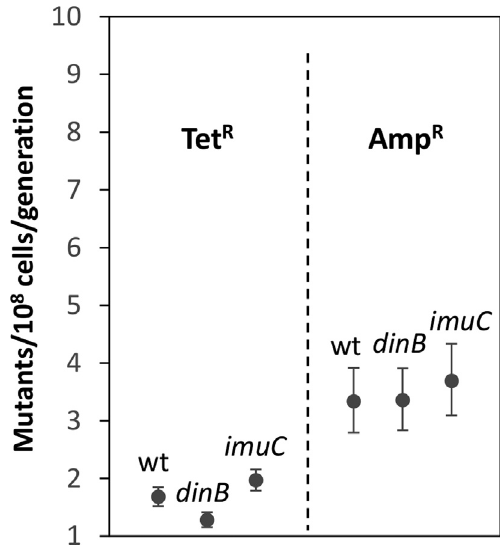
Figure 2 - Tet R and Amp R mutation rates. Tet R mutation rates were deter- mined using 66 cultures from 6 independent experiments. Amp R mutation rates were determined using 55 cultures from 5 independent experiments. Both the parental strains containing the cItet and xylbla markers (wt) and their dinB and imuC derivatives were analyzed. Mutation rates and 95% confidence intervals (represented by the error bars) were calculated using the MSS-MLE (Ma-Sandri-Sarkar Maximum Likelihood